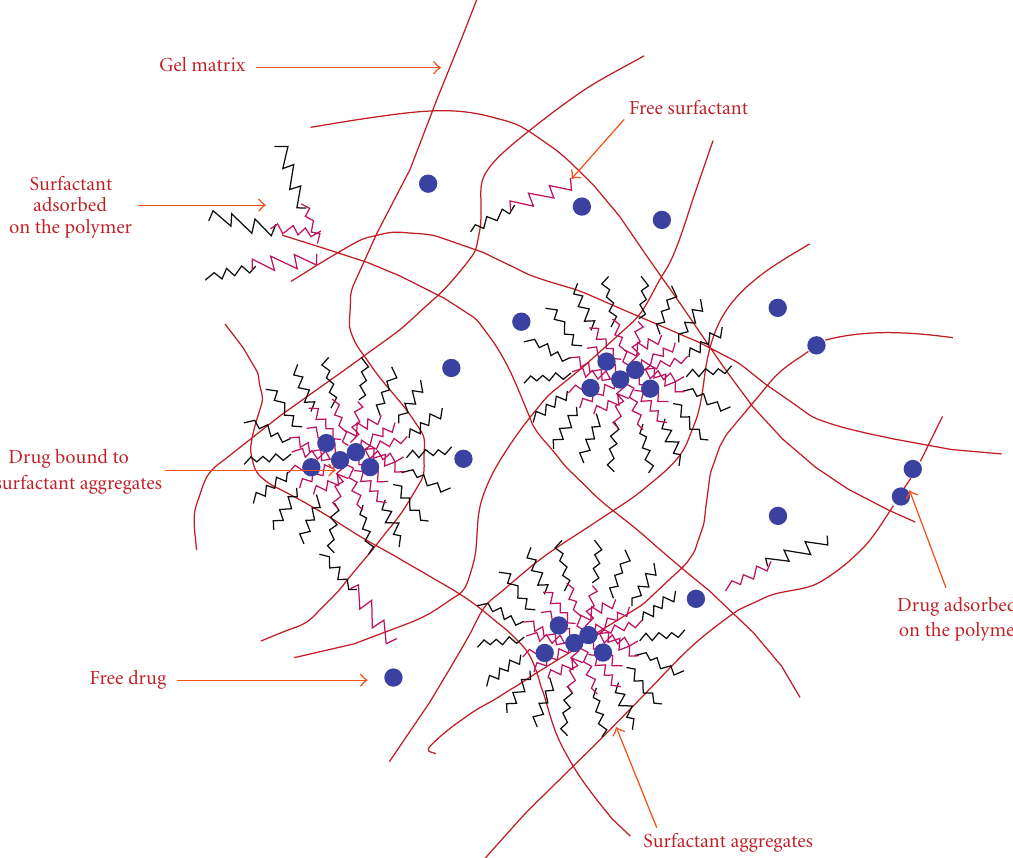
Figure 2: A schematic of the microstructure of the surfactant-laden gels